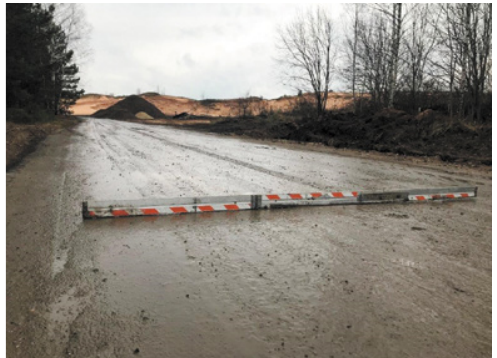
Figure 7. Full-scale test section No. 1